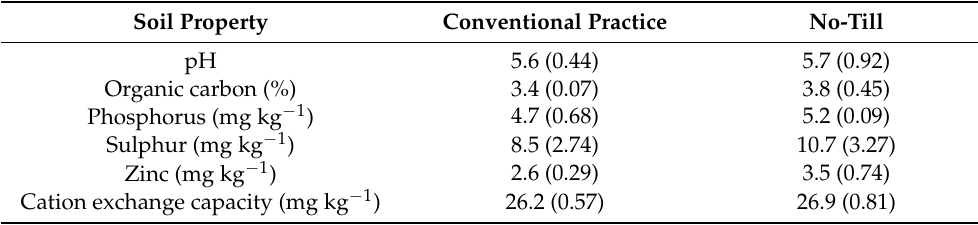
Table 1. Soil properties measured four years after introducing 2 WT direct planting in maize systems of the Gudeya-Billa District. Figures in brackets are the standard deviation of each